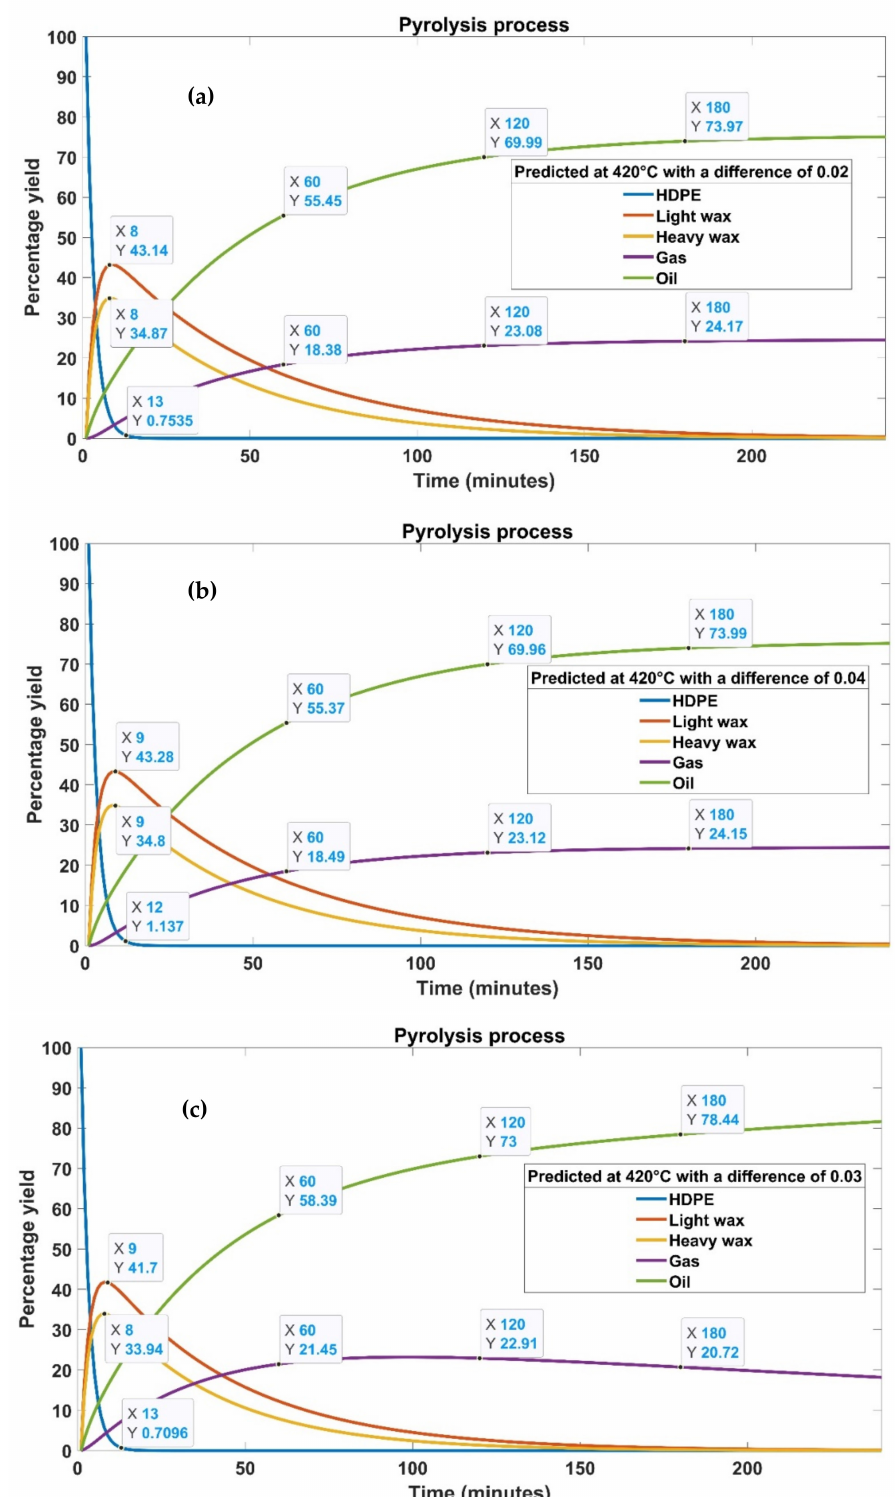
Figure 12. Graphical illustration of product type and yield for statistically predicted rate constants with a difference of ( a ) 0.02, ( b ) 0.03, and ( c ) 0.04 from the experimentally fixed